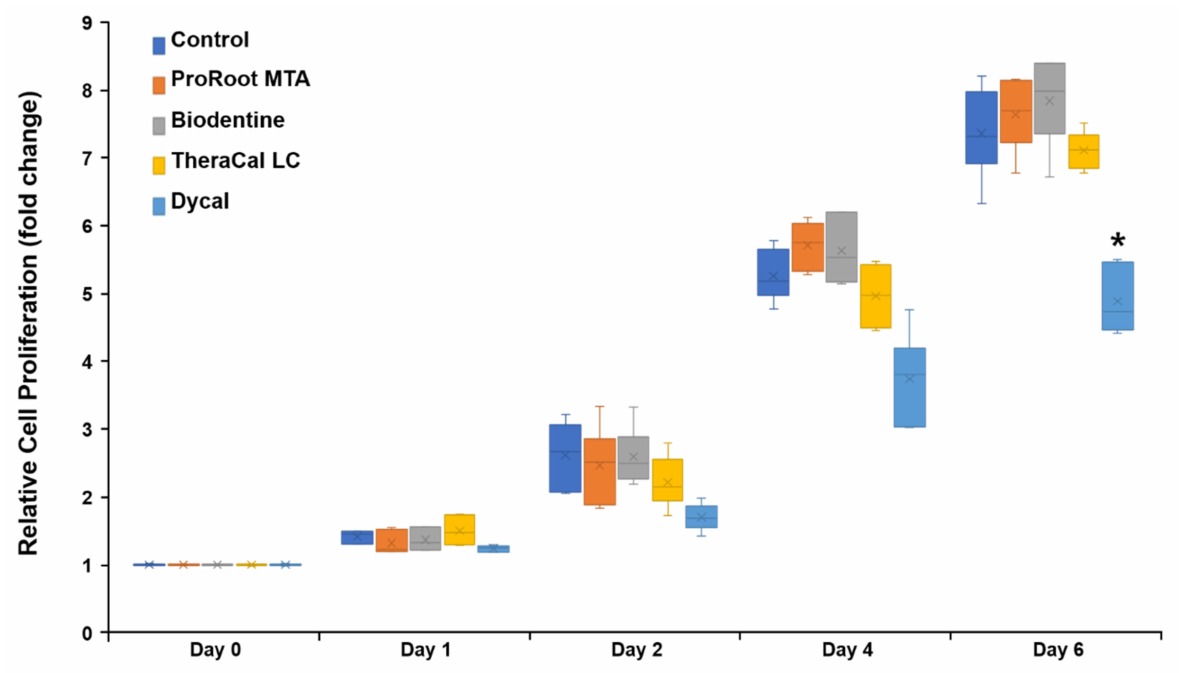
Figure 1. Relative proliferation of hDPSCs incubated with various pulp-capping materials, based on the cell-counting kit-8 (CCK) assay. * Statistically significant difference between the Dycal and control